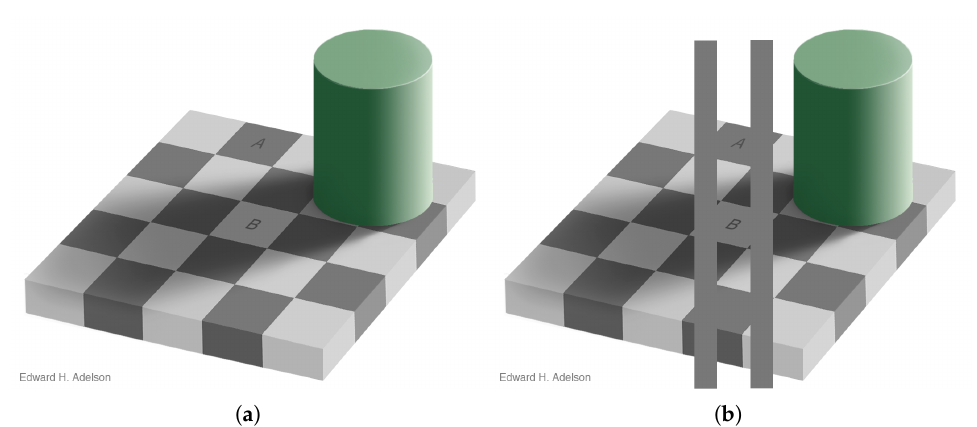
Figure 2. An example image of brightness perception published by Edward H. Adelson [26]. ( a ) The Checker shadow illusion image; ( b ) proof